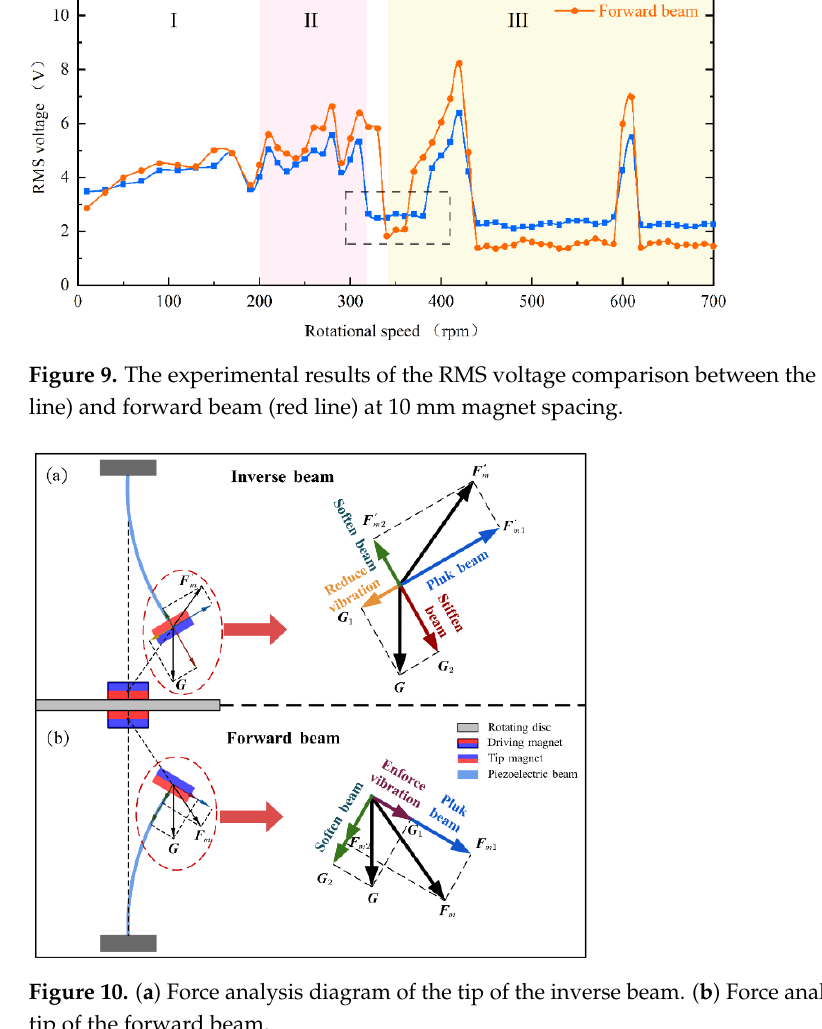
Figure 10. ( a ) Force analysis diagram of the tip of the inverse beam. ( b ) Force analysis diagram of the tip of the forward beam.